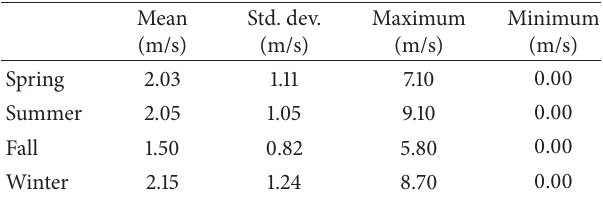
Table 1: Descriptive statistics of seasonal wind speed